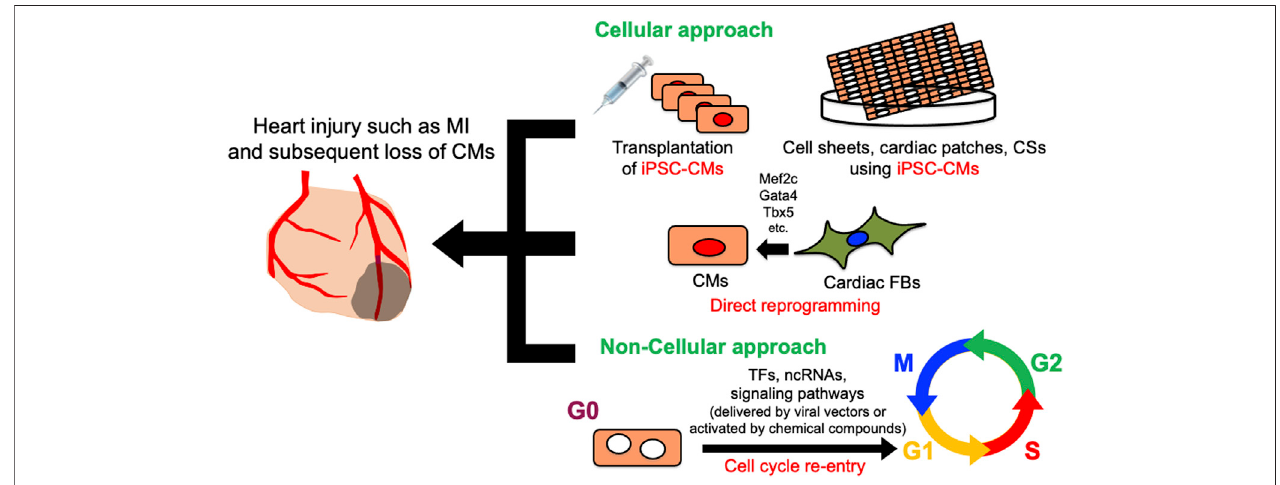
FIGURE 1 | Schematic diagram of cellular and non-cellular approach for heart regeneration therapy. Cellular approach includes iPSC-CMs and CMs derived from cardiacFBsbydirectreprogramming.Innon-cellularapproach,variousgenes,ncRNAs,andsignalingpathwayspromoteheartregenerationbyinducingcardiomyocyte cell cycle re-entry. CMs, Cardiomyocytes; CFs, cardiac fi broblasts; CSs, cardiac spheroids; iPSC-CMs, induced pluripotent stem cell-derived cardiomyocytes; TFs, transcription factors; ncRNAs, non-coding